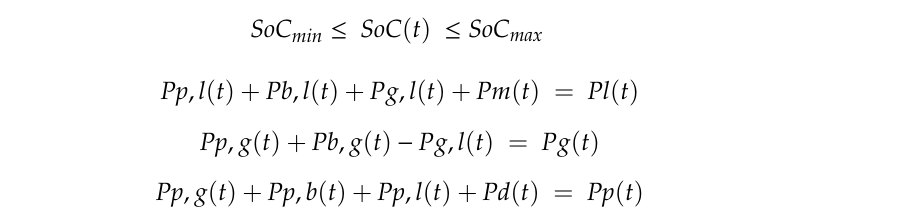
Figure 7. Power exchanged in the microgrid.